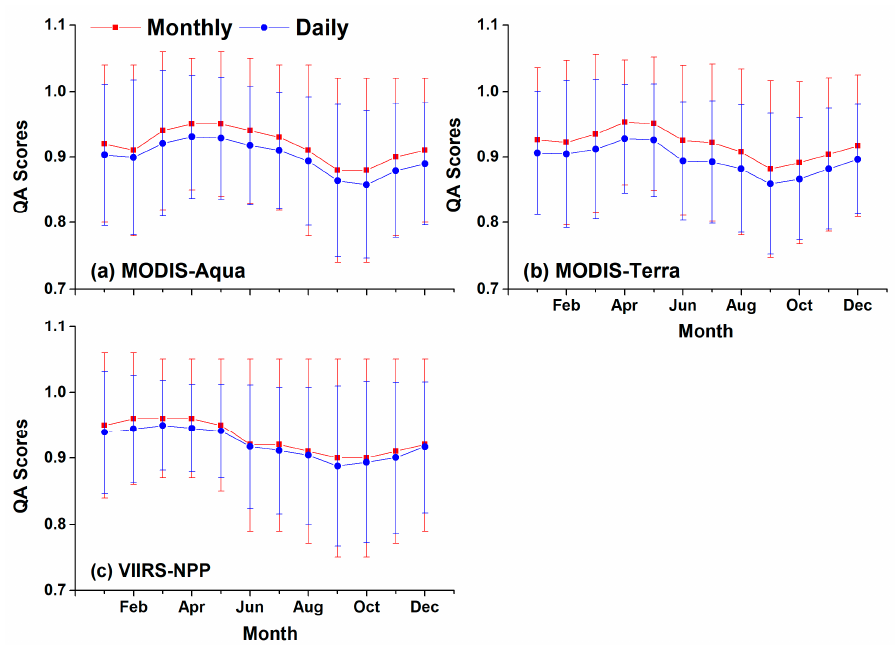
Figure 13. Comparison between QA scores based on level 3 daily and monthly R rs ( λ ) products from MODIS-Aqua ( a ), MODIS-Terra ( b ), and VIIRS-NPP ( c ).